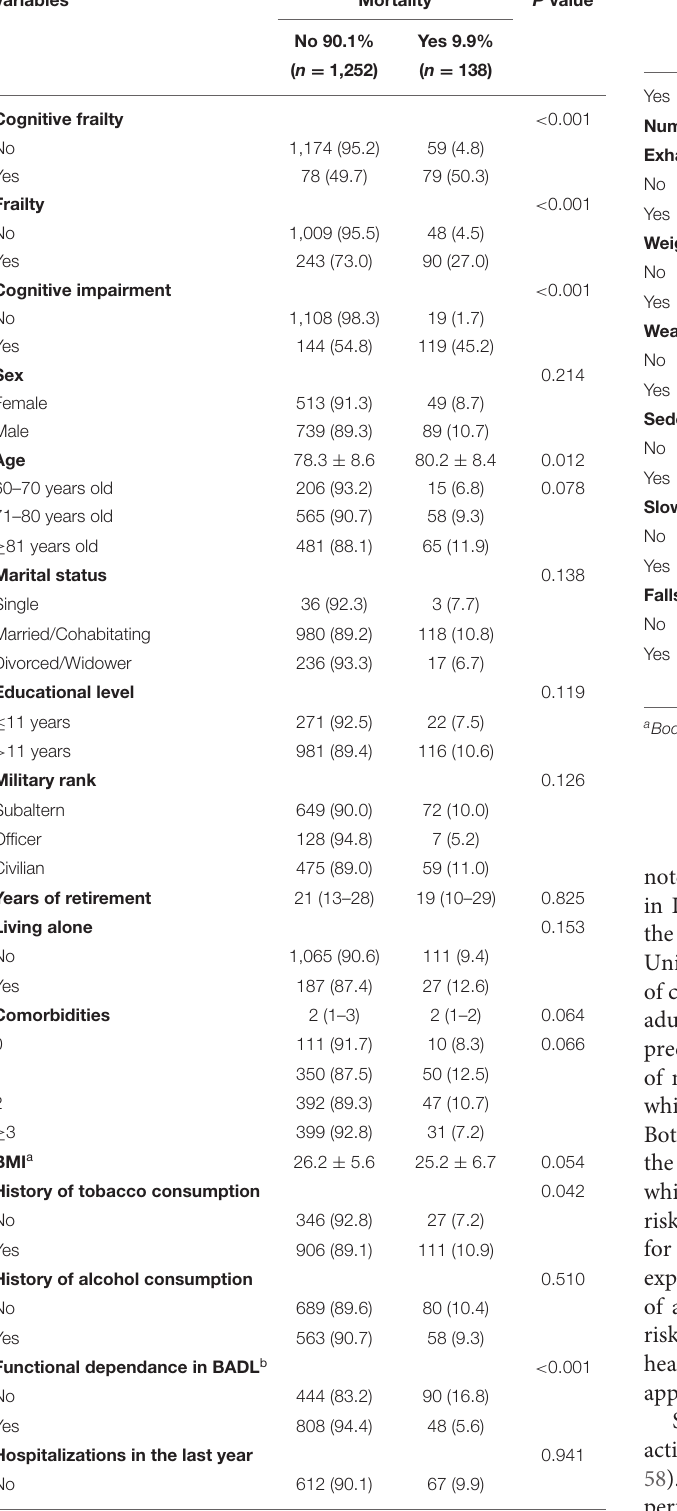
TABLE 2 | Descriptive and bivariate analyses of the study variables based on all-cause mortality ( n = 1,390).